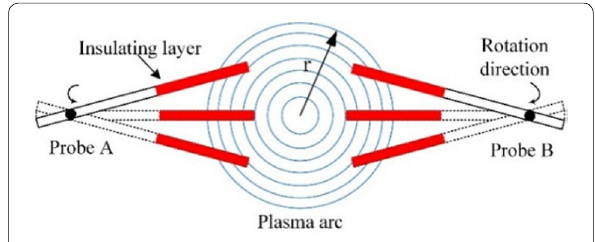
Figure 2 Diagram of the probes rotating into the plasma arc